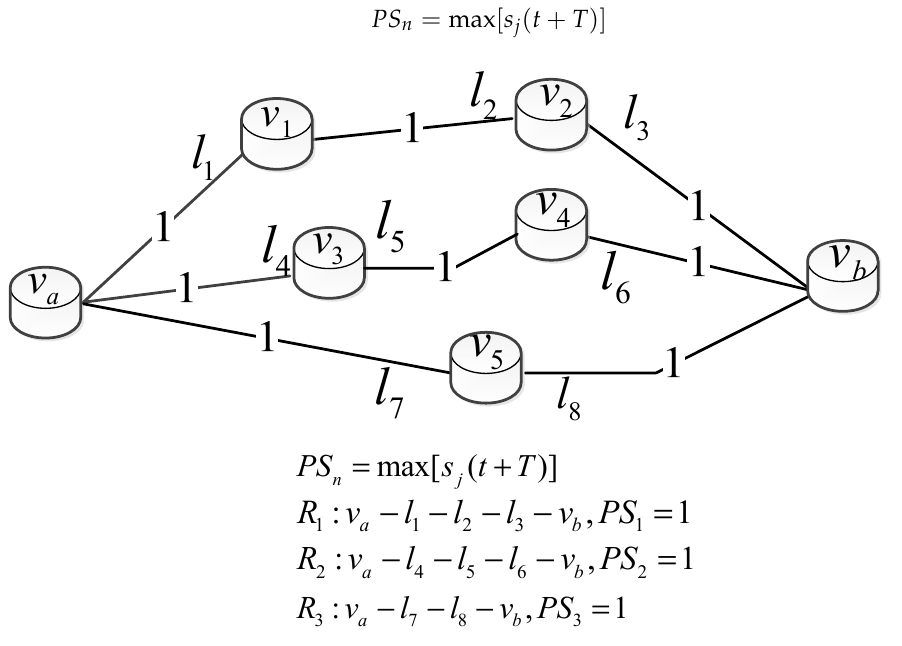
Figure 11. The path bandwidth occupancy rate at time t + T .